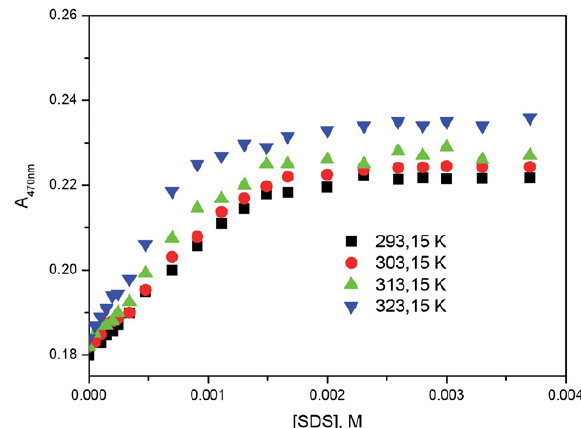
Figure 4. The variation of absorbance with SDS concentration at different